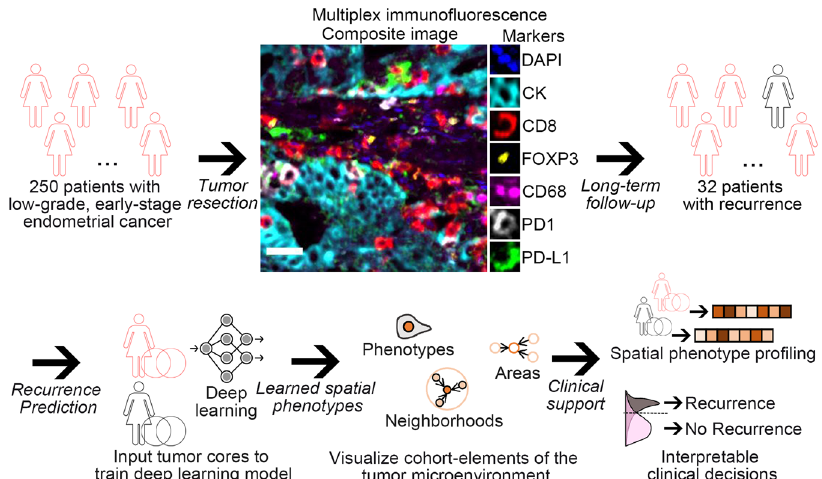
Fig. 1 Arti fi cial intelligence (AI)-based spatial phenotyping work fl ow to predict tumor recurrence in low-grade, early-stage endometrial cancer (EC). 250 patients with early-stage, low-grade endometrial cancer who underwent surgical resection were included in this study. Thirty-two tumors recurred over the follow-up period (mean 95.8 months). Tumor cores from primary tumor resection were stained using multiplexed immuno fl uorescence for the simultaneous visualization and quanti fi cation of CD68 of macrophages, CD8 + T cells, FOXP3 + regulatory T cells, PD-L1 and PD-1 protein expression, and tumor cells. NaroNet, a weakly-supervised deep learning framework, was applied to learn, without manual expert annotation, the complex tumor-immune interrelations at three levels: local phenotypes, cellular neighborhoods, and tissue areas. Our proposed method could accurately predict recurrence in EC, outperforming current prognostic factors, including molecular subtypes. Scale bar, 25 μ